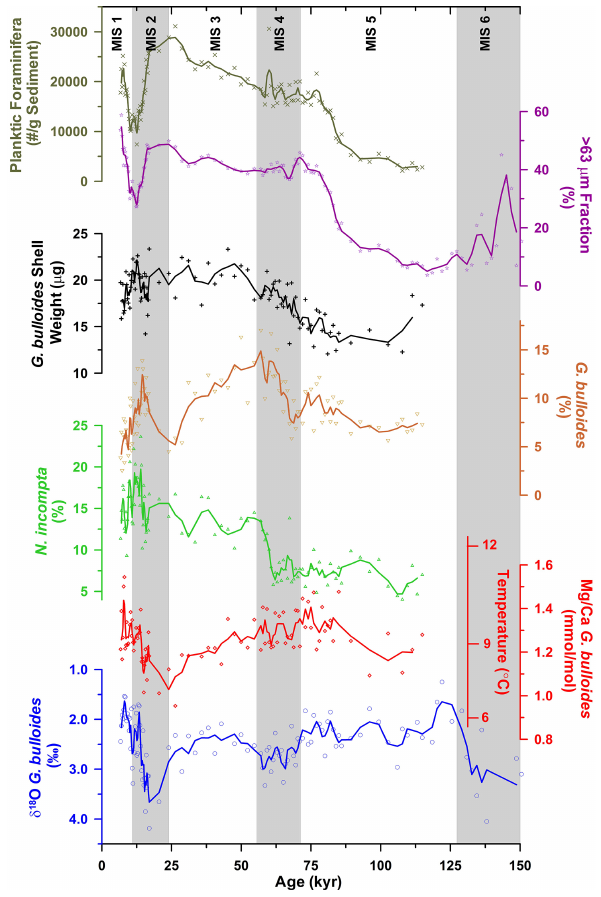
Fig. 3. Down-core variation in size fraction > 63µm, planktic foraminiferal abundance (TPF/g sediment), average Globigerina bulloides shell weight, relative abundance of G. bulloides and Neogloboquadrina incompta , G. bulloides Mg/Ca along with esti- mated seawater temperature and δ 18 O. The symbols are the actual values, while the solid line is the three-point running